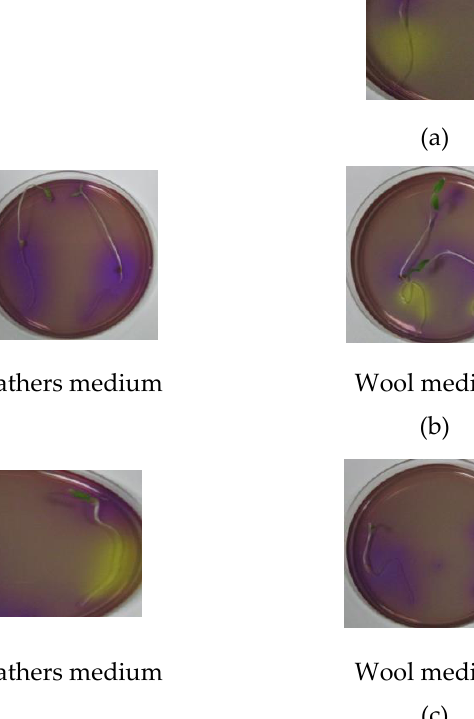
Figure 6. Proton pump test applied to tomato seedlings treated with PHs from Trichoderma isolates compared. ( a ) Tomato seedling treated with tap water (control). ( b ) Treatment with PHs from T. atroviride grown on di ff erent media. ( c ) Treatment with PHs from T. asperellum grown on di ff erent media. Pictures show root acidification activity of 10 days old seedlings treated with fungal PHs for 60 min. The yellow color indicates acidic pH, purple color denotes neutral to alkaline pH.